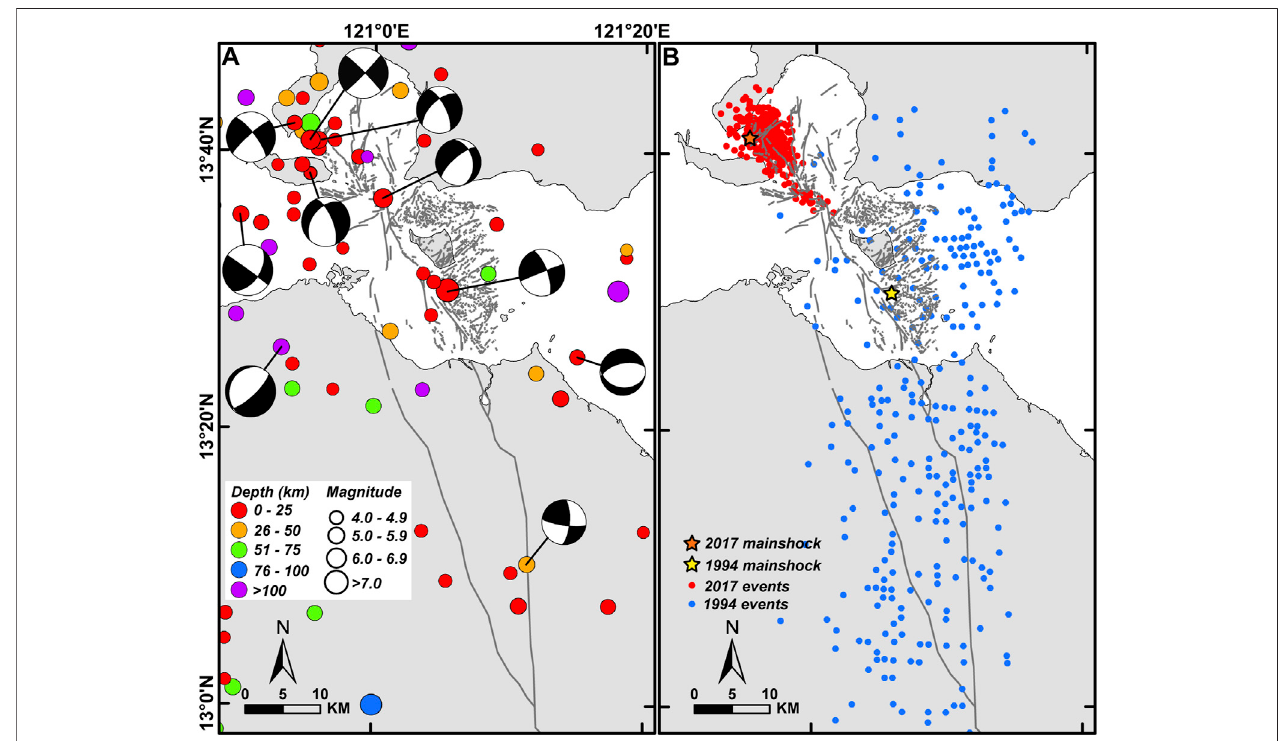
FIGURE10| Correlationofinterpretedstructurestoearthquakedata. (A) ColoredcirclesareinstrumentalseismicityfromPHIVOLCSCatalog(1907 – 2019).GCMT solutions are also shown using locations from the PHIVOLCS Catalog. (B) The 1994 earthquake aftershocks (PHIVOLCS Quick Response Team, 1994) and 2017 earthquake sequence (Chen et al., 2020) show an apparent boundary where ARF and BBFS